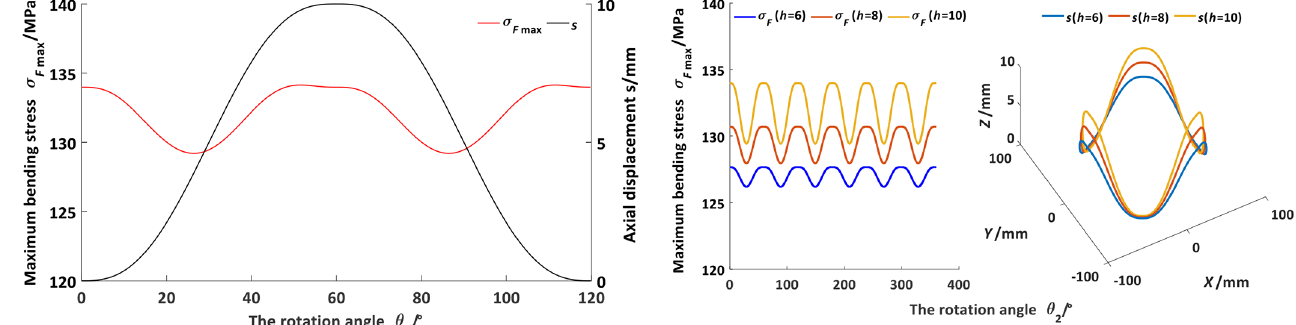
Fig. 12. In fl uence of h on s F and s.